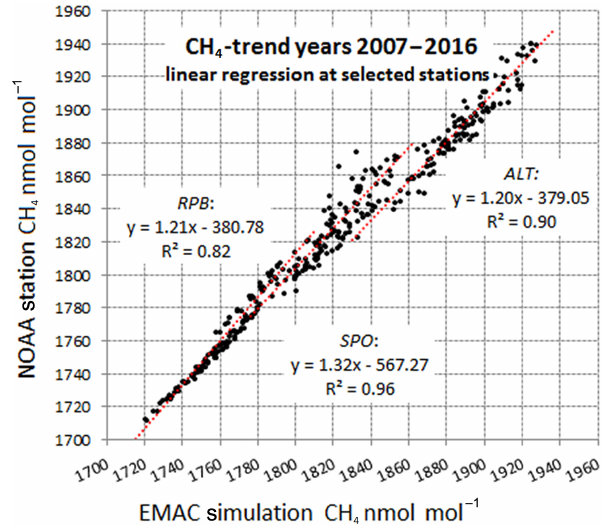
Figure 11. Regression analysis of EMAC calculations vs. observa- tions of CH 4 at NOAA stations ALT, RPB, and SPO for the trend years